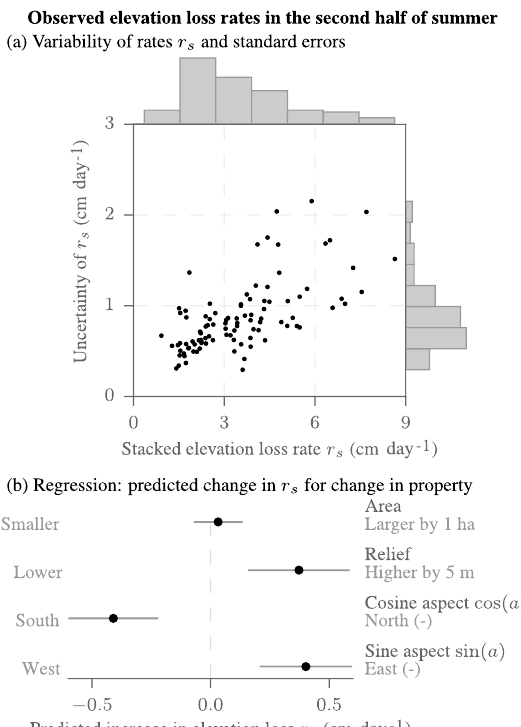
Figure 6. Seasonal elevation loss rates r s at slumps (both orbits) in the Tuktoyaktuk coastlands, temporally averaged between 15 July and 28 August 2015. (a) Scatter plot of r s estimates and their stan- dard error. (b) Dependence of r s on slump features as predicted by the regression model: the dots show the predicted change in r s for a change in the property of the annotated magnitude (e.g. 5m in- crease in headwall relief); the bars indicate plus/minus 1 standard